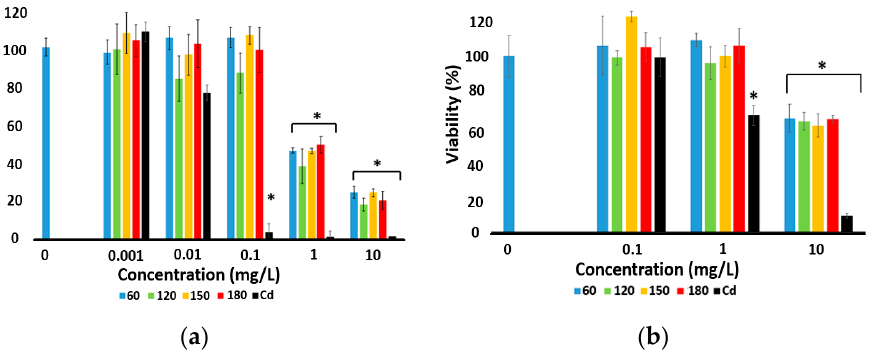
Figure 4. Viability (%) of CHO-K1 ( a ) and HEP-G2 ( b ) cells exposed to CdSTe QDs synthesized at different temperatures (60, 120, 150, and 180 °C) and cadmium solution at concentrations from 0.001 to 10 mg/L (CellTiter-Glo ® luminescent cell viability assay) for 24 h. * statistical difference.